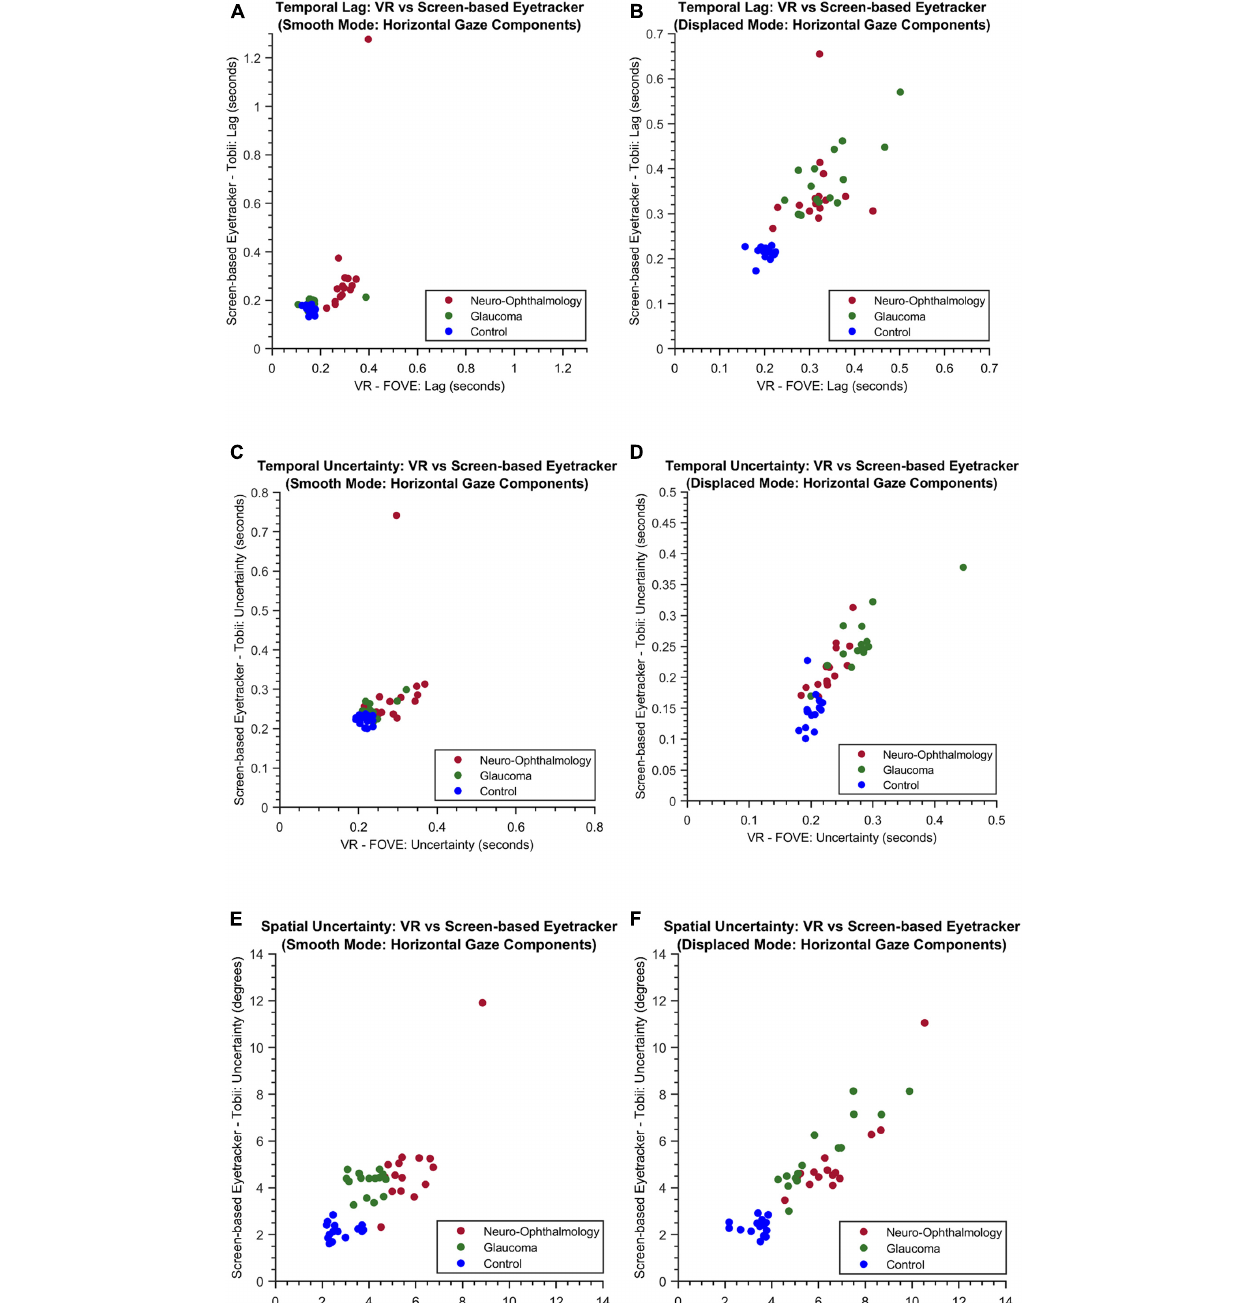
slow performance during smooth pursuit (mean temporal lag is the highest – Figures 2A,B ) and are rather inconsistent in their ability to track the smoothly moving stimulus [both the mean temporal and spatial uncertainty values are high – Figures 2C–F )]. This behavior agrees with the literature,